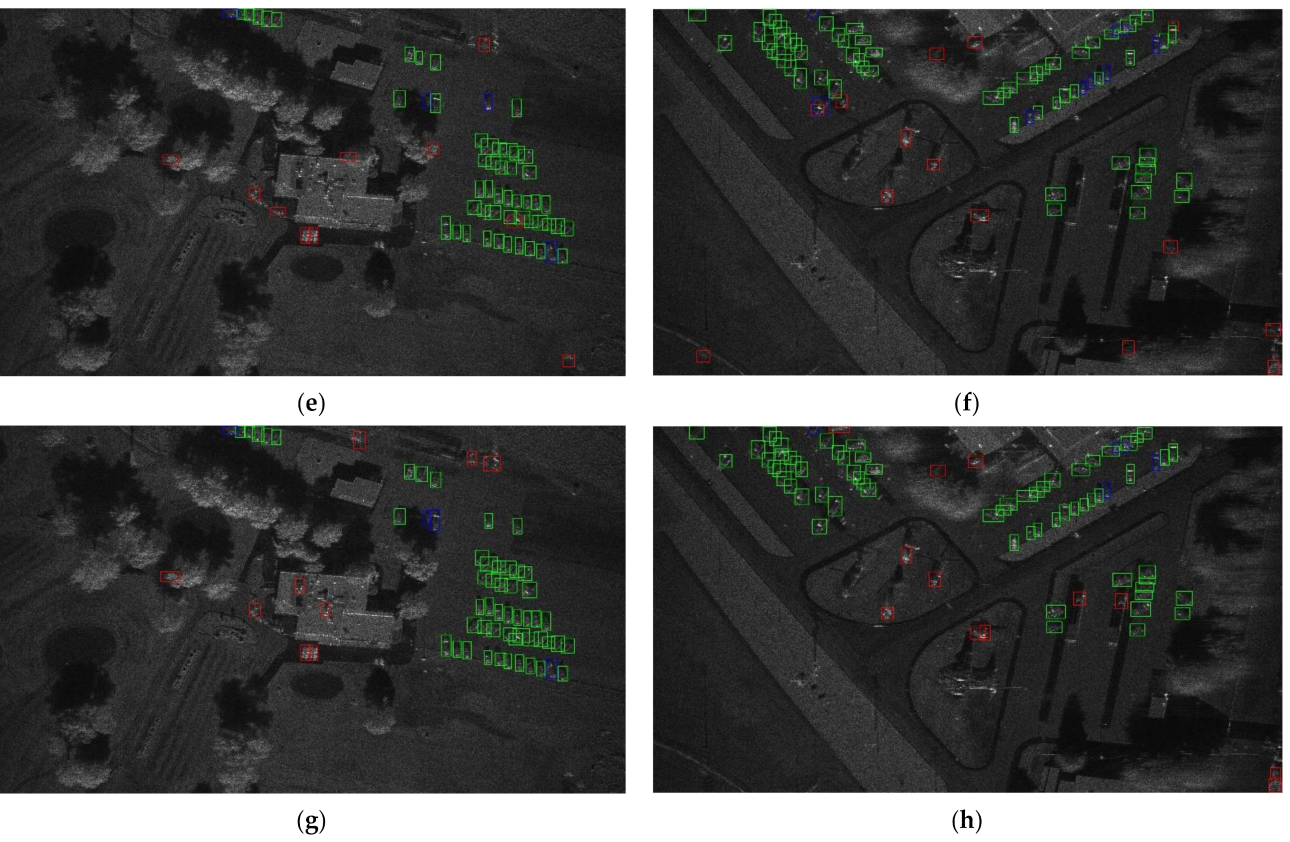
Figure 4. The SAR target detection results of the proposed method comparing with the comparisons for the two test images of miniSAR dataset. ( a , b ) are the results of Gaussian-CFAR; ( c , d ) are the results of Faster R-CNN; ( e , f ) are the results of Faster R-CNN with initialized operation; ( g , h ) are the results of our